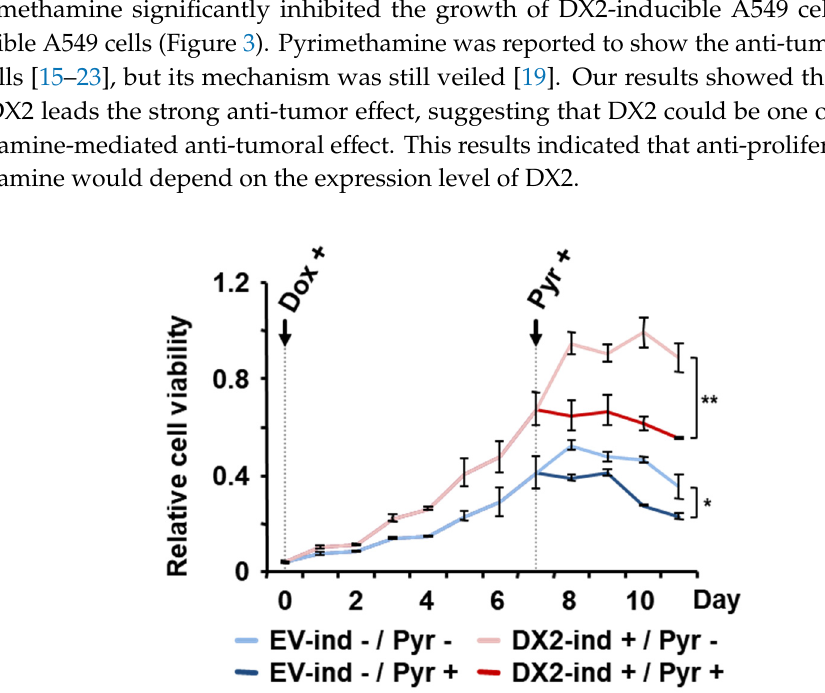
Figure 3. Significance of the DX2 level on pyrimethamine-mediated suppression of cancer cell viability. DX2- or EV-inducible (ind) A549 cells were treated with doxycycline (Dox) and pyrimethamine (Pyr) at the indicated time to induce the expression of DX2 and to reduce cell viability, respectively. The values on the graph were calculated against cell viability of empty vector (EV)-inducible cell lines at time 0 and presented as a relative cell viability. The experiments were independently repeated three times. Student’s two-tailed t-test was performed for statistical analysis (* p < 0.05, ** p < 0.01). The error bars denote the standard deviation (S.D.), the data shown are the mean ± S.D.